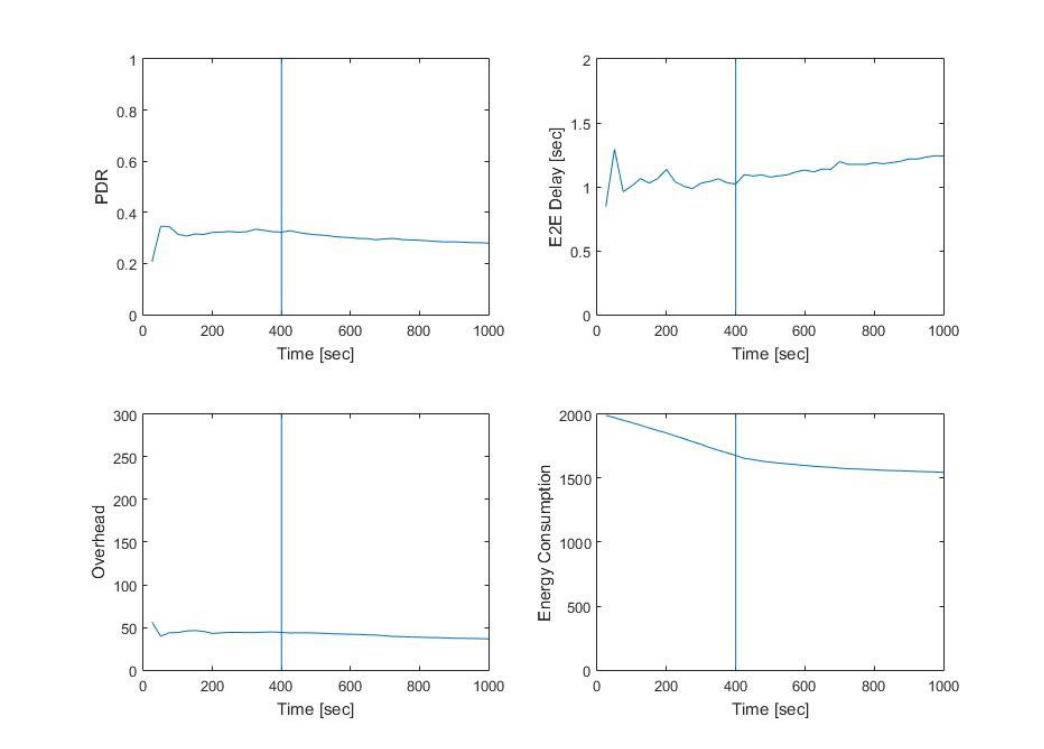
Fig. 4. Evaluation of OLSR protocol based on 20 mobile sensor nodes